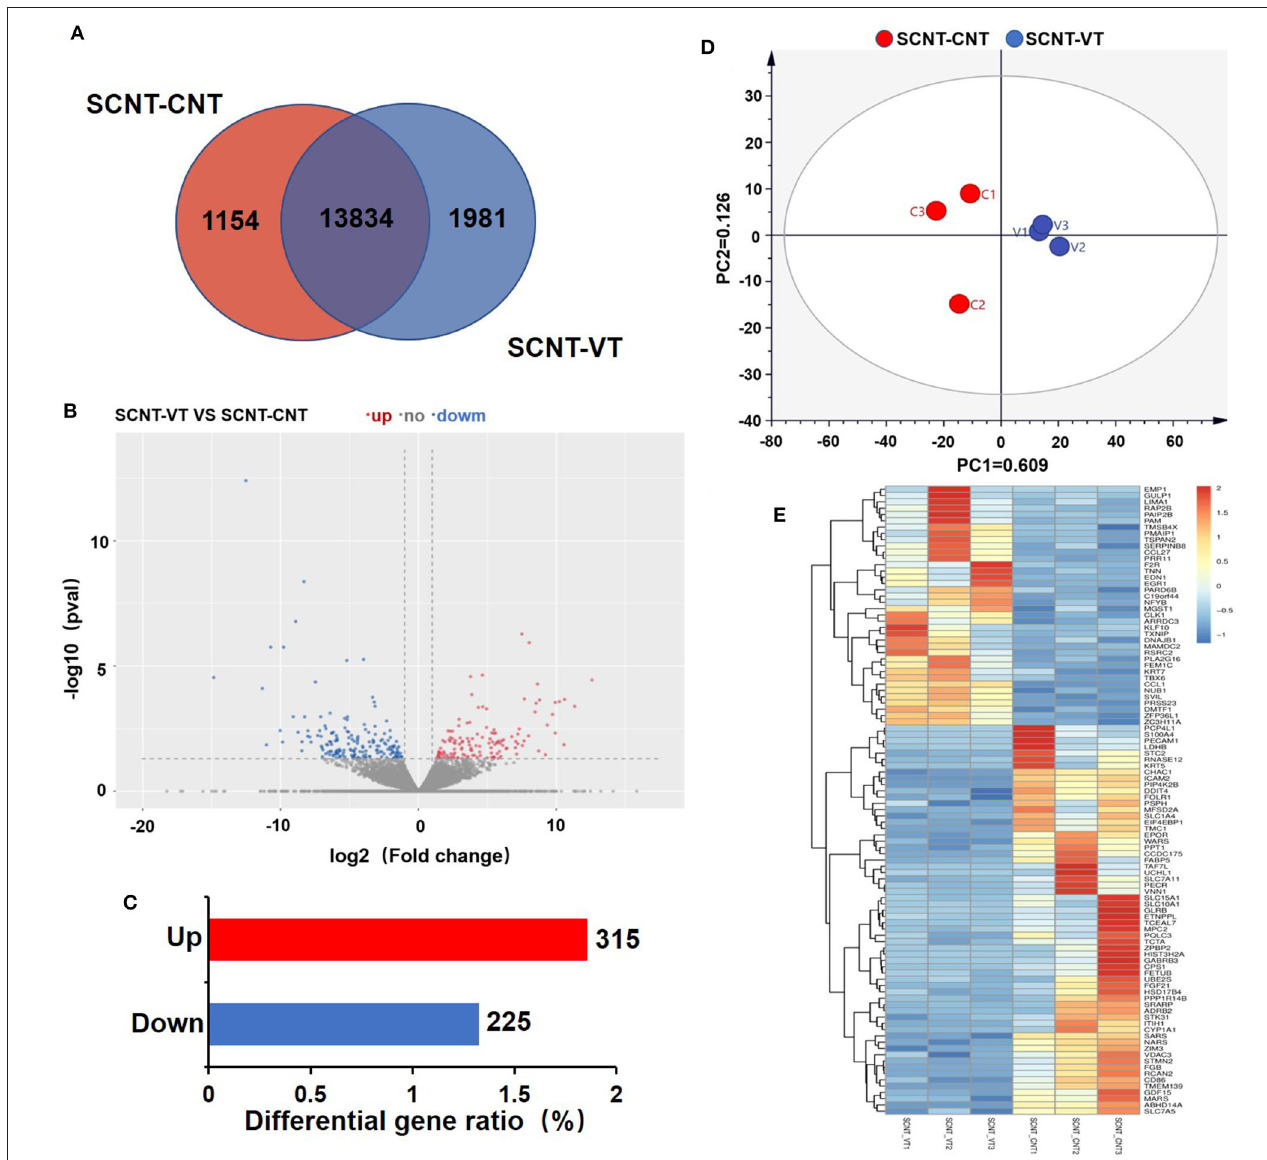
FIGURE 2 | Differentially expressed genes (DEGs) in control and vitrified/thawed porcine cloned blastocysts. (A) Venn diagram showing the expression of genes between the control and experimental groups; each circle indicates gene expression between the two groups. (B) Volcano plot depicting significant differences in gene expression between the control and experimental groups. (C) Bar chart showing DEGs that were up- (red bars) and downregulated (blue bars). (D) Two-dimensional principal component analysis showing DEGs in the control and experimental groups. (E) Clustering analysis of gene expression levels (measured in “fragments per kilobase of exon model per million mapped reads”). Red indicates upregulation and blue indicates downregulation.